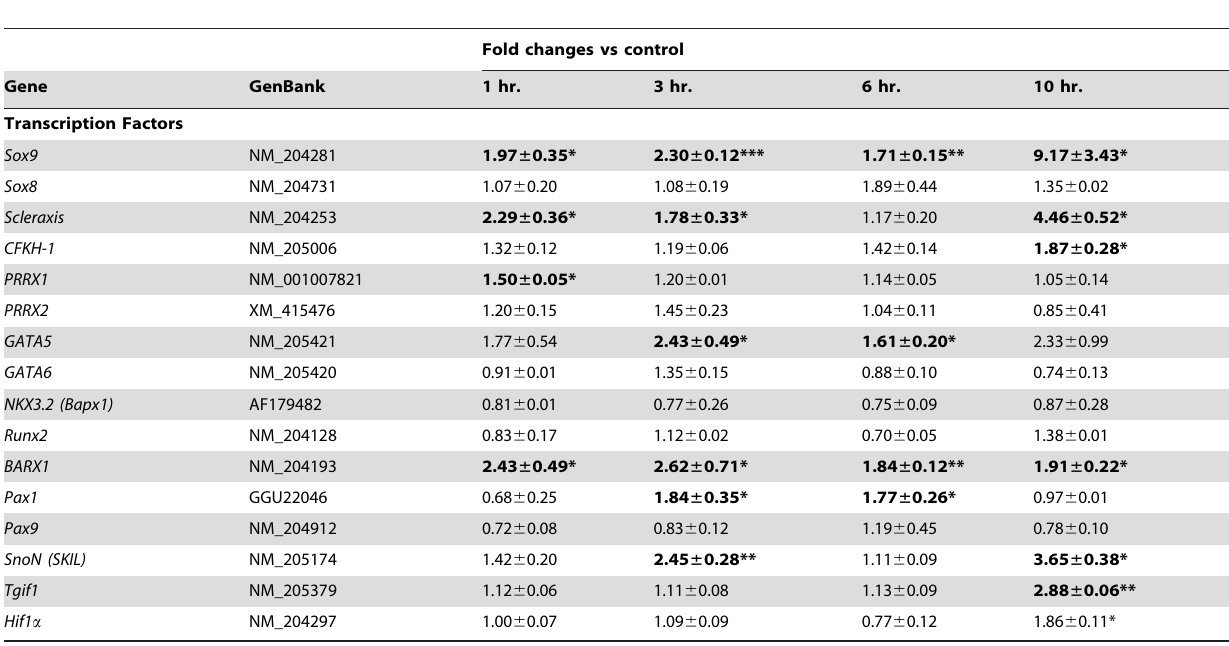
Table 2. Regulation of transcription factor encoding genes at 1, 3, 6, and 10 hr after interdigital implantation of beads bearing Tgf- b 1.